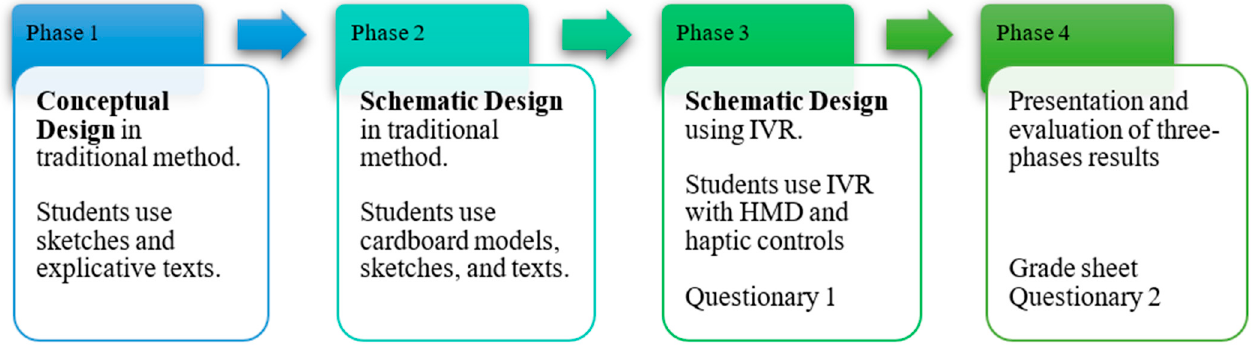
Figure 2. The four phases of experimental design.